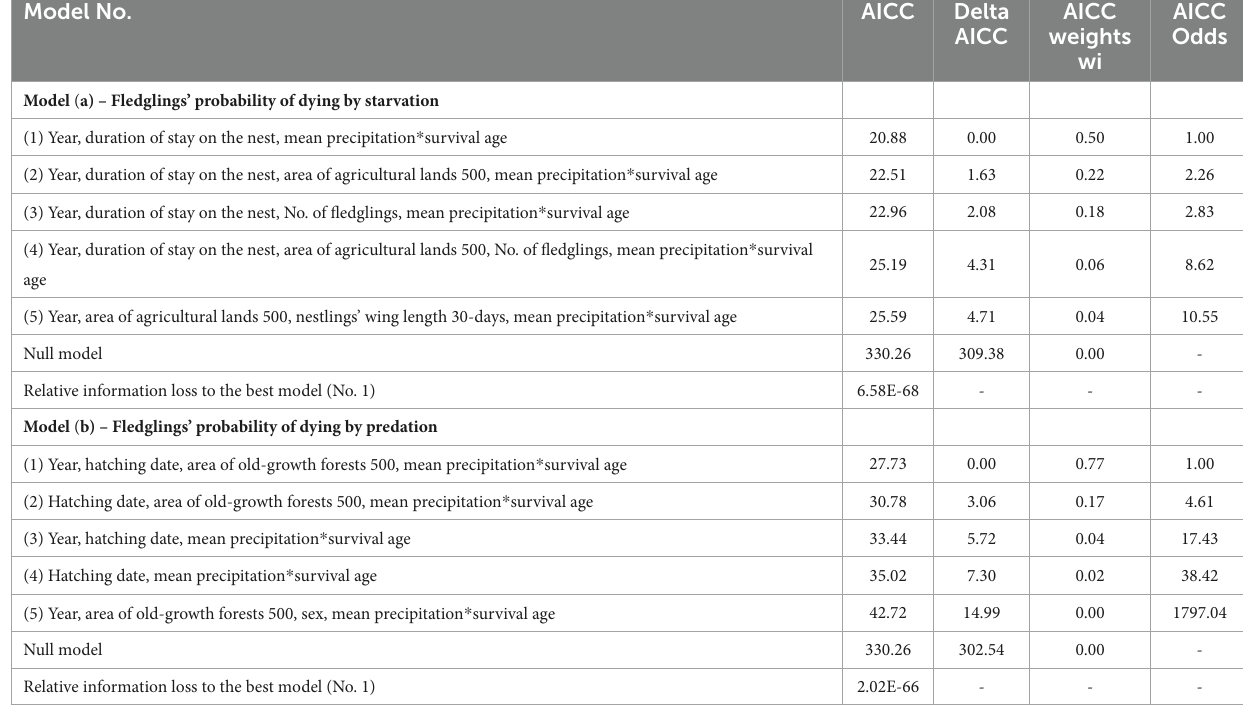
TABLE 3 Composition of the best models. Model